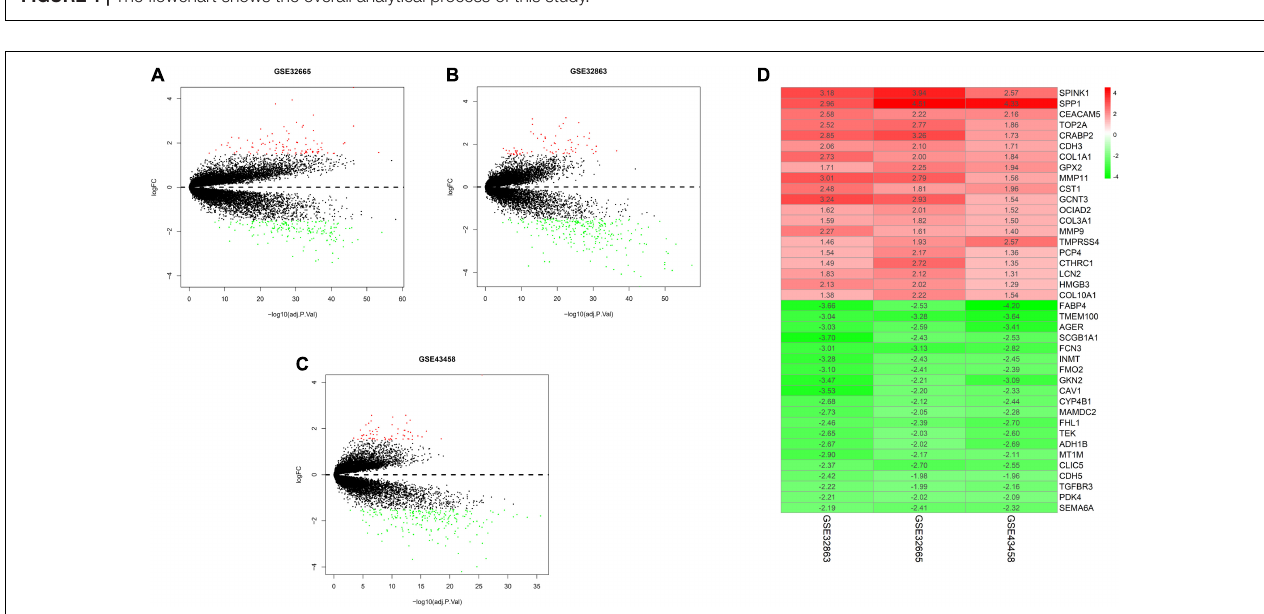
FIGURE 1 | The flowchart shows the overall analytical process of this study.